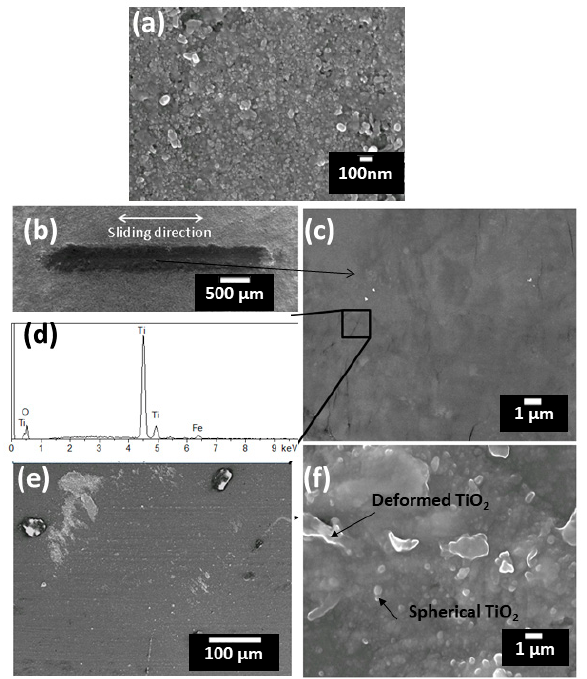
Figure 10. Coating S1: ( a ) cross-sectional SEM view of coating S1, wear track under ( b ) low magnification and ( c ) high magnification; ( d ) EDS analysis of area in image; wear scar of counterpart Al 2 O 3 pin under ( e ) low magnification and ( f ) high magnification.